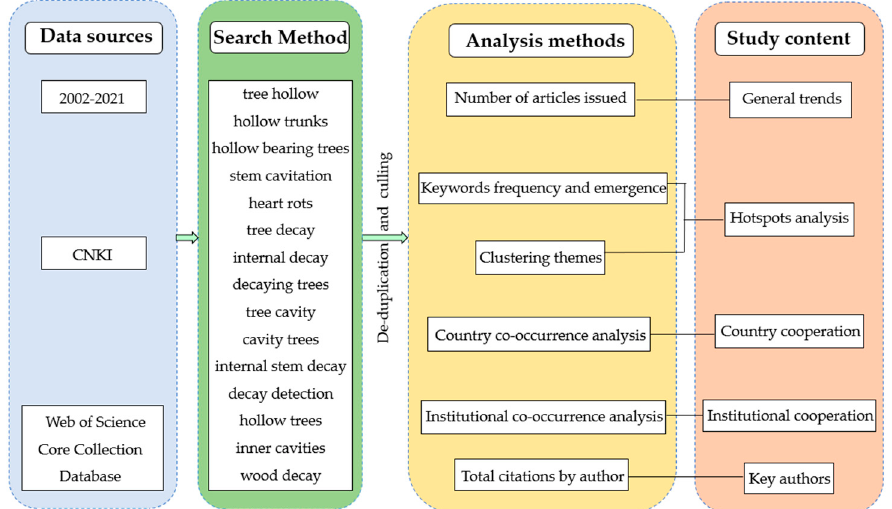
Figure 1. Data processing and research methods.